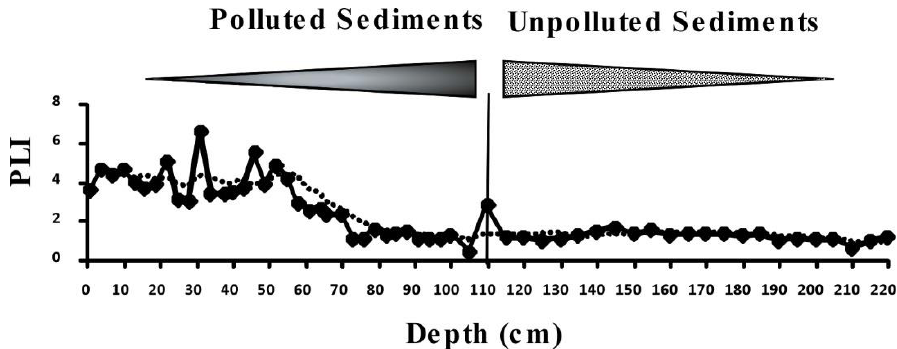
Figure 6. Pollution load index (PLI) variations in the Salam1 core from Al-Salam Lagoon along the Jeddah coast, Saudi Arabia. (Trend line of 5 Average is shown by dots).